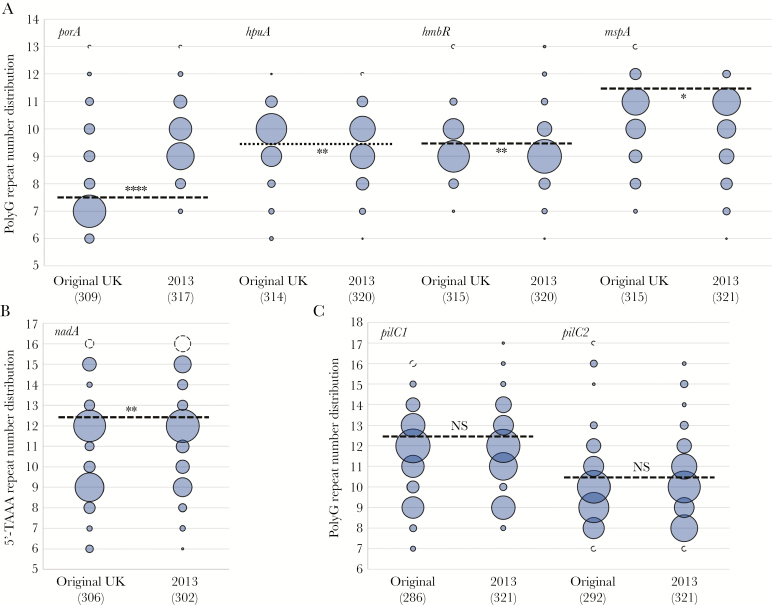
Significant changes in repeat number for 5 phase-variable single-copy outer-membrane protein (scOMP) genes but not pilC genes between the Neisseria meningitidis serogroup W (MenW) clonal complex 11 original UK and 2013 strains. Repeat numbers were determined for these phase-variable genes by bioinformatics analyses of whole-genome sequencing data for multiple disease isolates of the original UK and 2013 strains of the MenW ST-11 South American strain lineage. The total number of isolates of each strain type is shown in parentheses. Shaded bubbles represent the proportion of isolates with a particular repeat number. Non-shaded bubbles indicate the proportion of isolates with ≥ or ≤ for high and low repeat numbers, respectively. Dashed line, modal repeat number (note that the line is placed above the modal number); dotted line (hpuA), separates into different groups isolates with 9 and 10 repeats, which are the major repeat numbers associated with OFF and ON expression states, respectively; asterisks above or below the dotted line indicate significant differences in the proportion of isolates with repeat numbers above or below the mode, respectively, for the 2013 strain. NS, not significant. *P ≤ .05, **P ≤ .01, and ****P ≤ .0001.